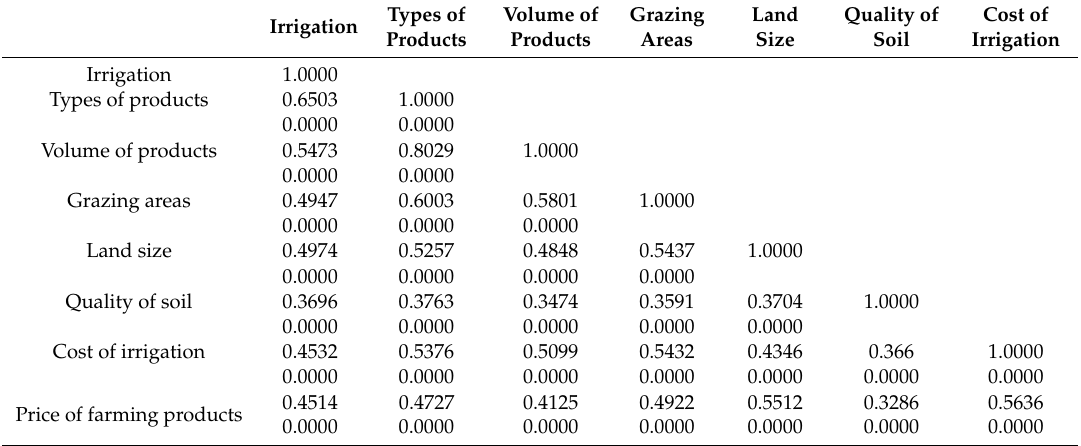
Table 5. Correlation among agricultural economic